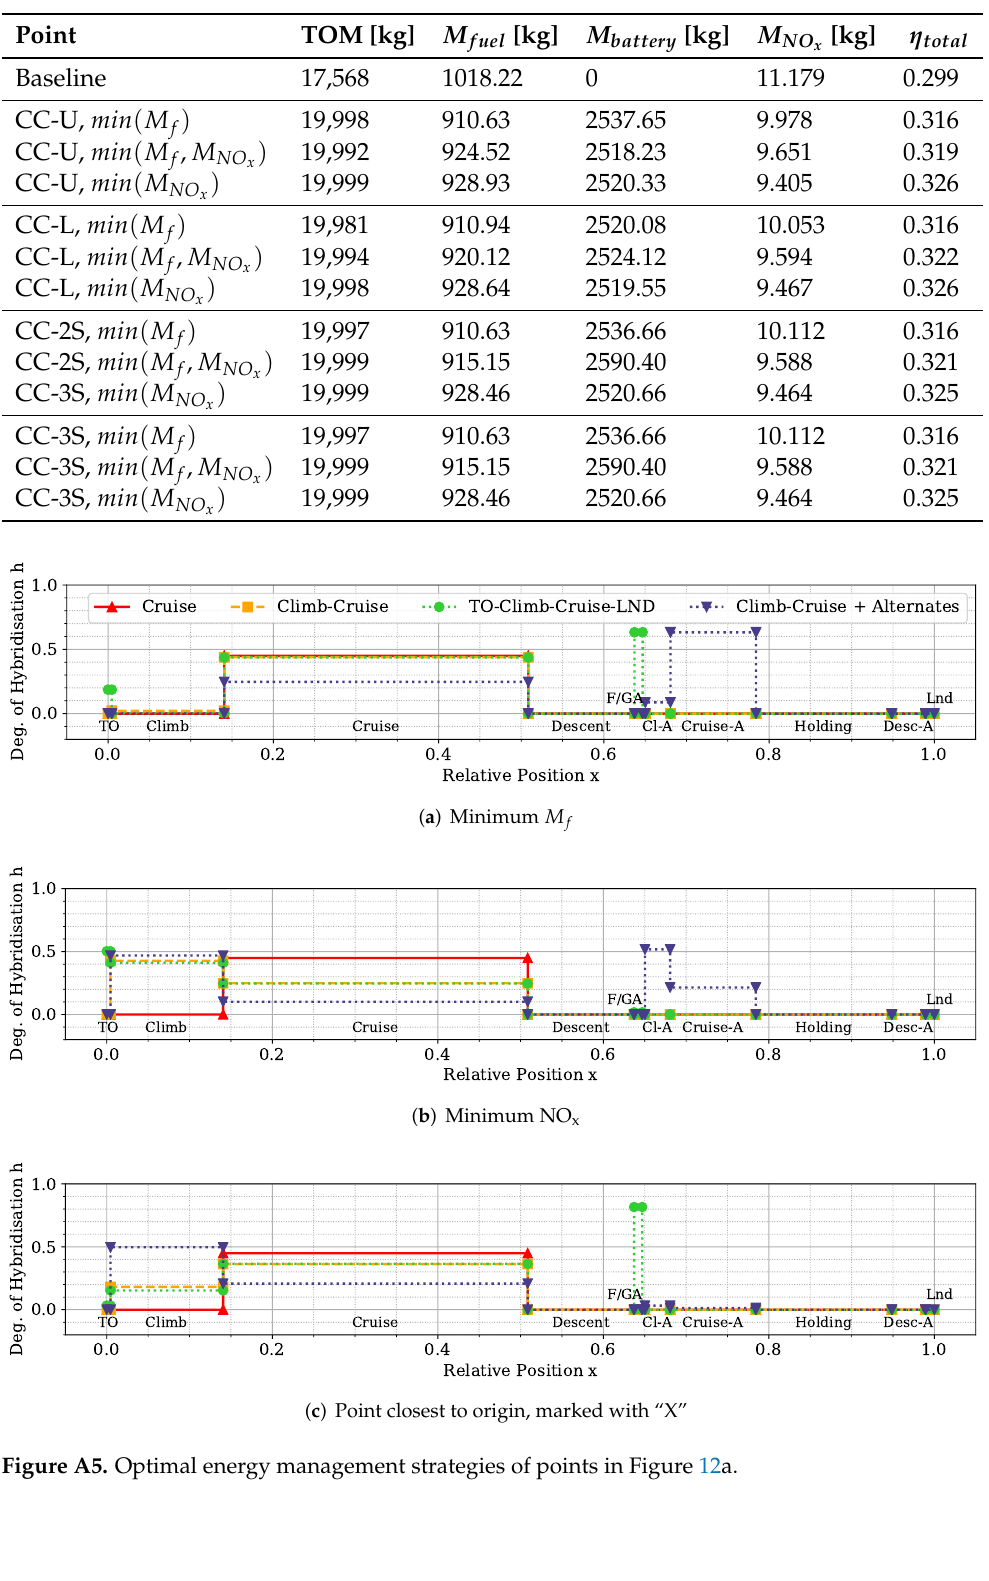
Table A1. Detailed results of the optimal points where Climb and Cruise are hybridised. (Section 5.2).